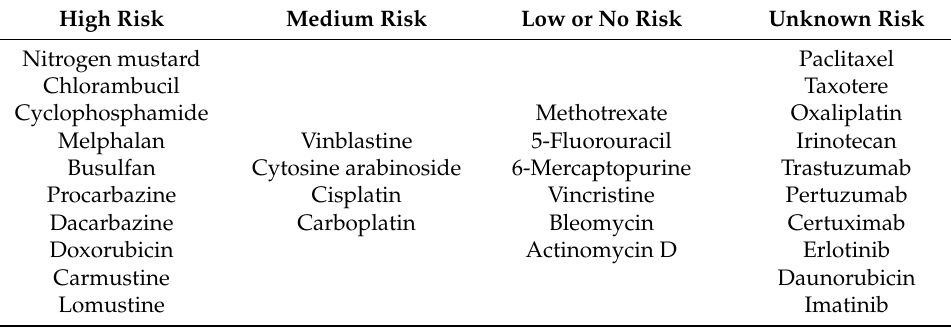
Table 1. Chemotherapeutic Agents and Risk of Gonadotoxicity.